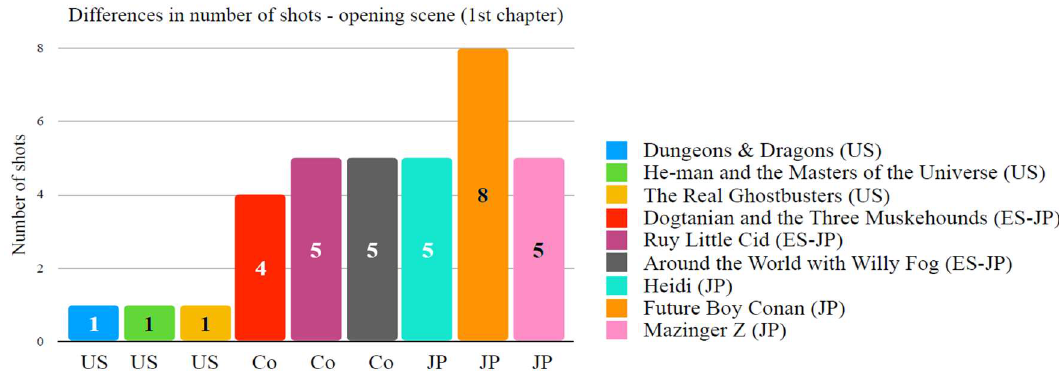
Figure 1. Comparative chart between some early 1980’s American cartoons, Japanese anime series and animesque Euro-Japanese co-productions, according to the number of shots used in the first chapter’s opening scene. Chart by author ©2018 José Andrés Santiago Iglesias.